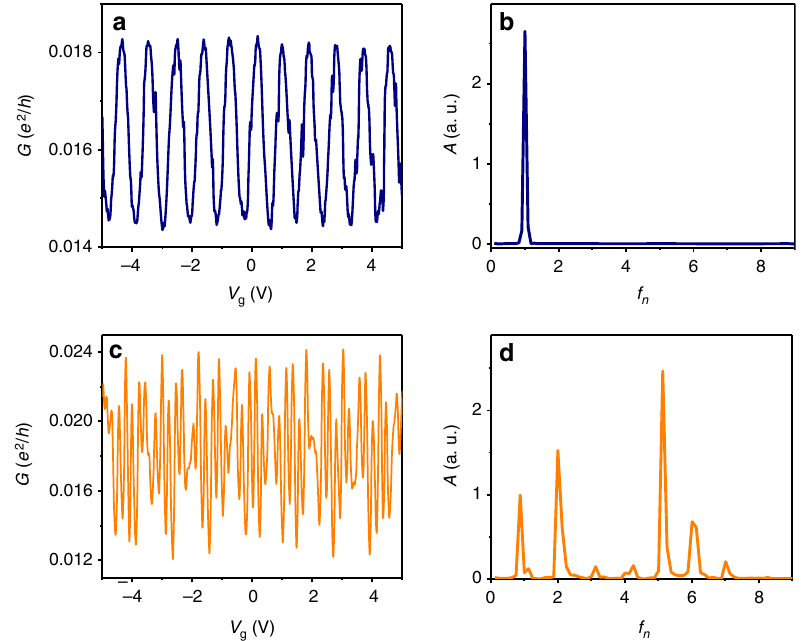
Fig. 3 Effect of coupling on the multiple-periodicity. a G ( V g ) for a strongly coupled dot ( η = 7.7 ± 0.1) and its Fourier transform b . c G ( V g ) for a weaker coupled dot ( η = 3.3 ± 0.1). d The Fourier transform of c showing seven different harmonics (the x -axis is in units of the base Coulomb blockade frequency f V = 1 mV. We note that the reason that the stronger coupled dot has a smaller conductance is the asymmetrical CB ). Both measurements were taken for SD coupling to the drain and source (see main